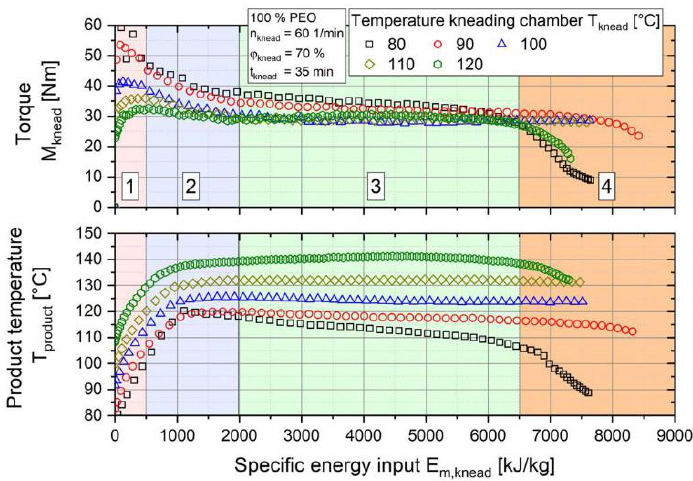
Figure 6. Influence of the processing temperature (T knead ) on the polymer PEO. The composite undergoes four steps: (1) Homogenization, (2) Plasticization, (3) Plasticized homogenization and (4) Degradation. Reprinted with permission of Journal of The Electrochemical Society, 2020, 167, 020558 [50]. Malik et al. pointed out the effect of temperature on the degradation of a SPE PEO- based blend [53], but Froboese et al. went further as they demonstrated that shear forces and filler content also have an impact on the resultant hybrid polymer electrolyte. Gel permeation chromatography (GPC) measurements on PEO show the chain lengths after different processing parameters and are reported in Figure 7. It reveals that increasing the shear rate as well as the filler content leads to a decrease in PEO molecular weight. This shows that all cited parameters impact the resulting composite and compromises need to be made. The optimal parameters window is very narrow, and polymer degradation should always be considered when the extrusion process is used. Moreover, the results presented for PEO with the tested parameters, will obviously be different for each poten- tial polymer used as a matrix. The extrusion process is a powerful method to make hybrid polymer electrolytes. It has the advantage of being fast and can ensure a high degree of dispersion and homoge- neity of the composite. Nevertheless, the temperature and shear rate imposed during the mixing must be carefully considered as they impact the polymer matrix that is used.